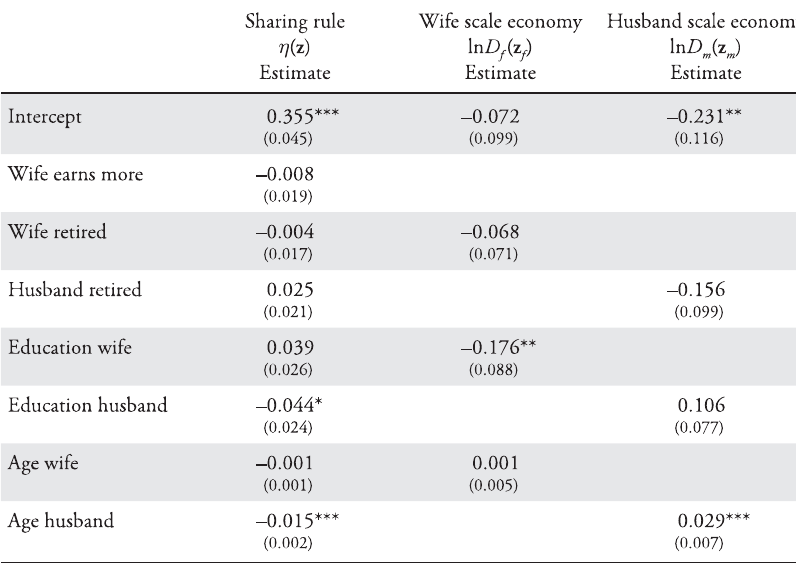
Table 10: Estimates for the Restricted Modd without Price Elasticity Param.cten Sharing rule Wife scale economy Husband scale economy 1J(z) lnD,<7) lnD.(z..)